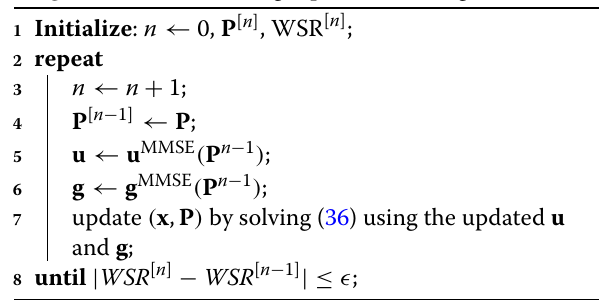
Algorithm 1: Alternating Optimization